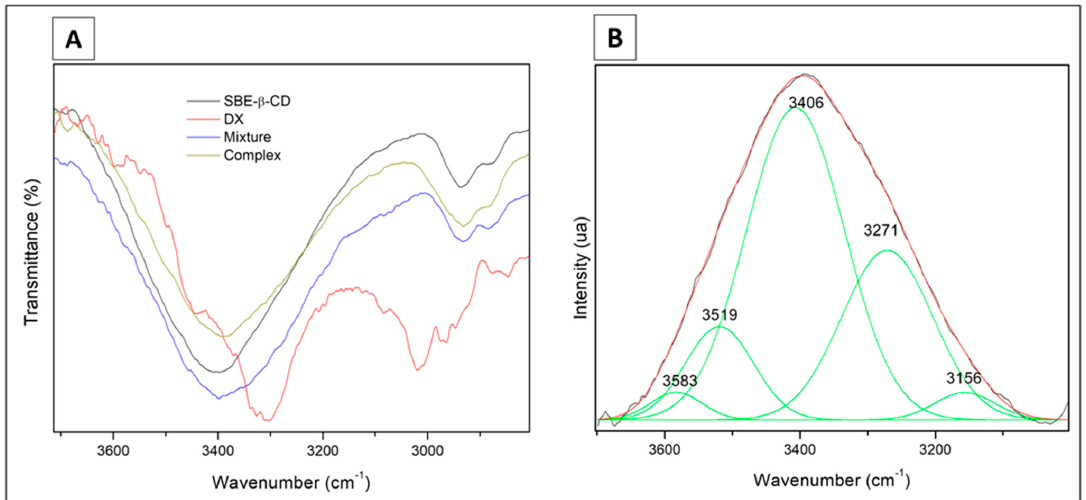
Figure 5. Infrared spectra from 3700 to 3000 cm − 1 plo tt ed as transmi tt ance vs. wavenumber ( A ) and intensity vs. wavenumber ( B ) for samples of doxycycline (DX), sulfobutylether- β -cyclodextrin (SBE- β -CD), physical mixture, and freeze-dried complex (1:1 molar ratio).